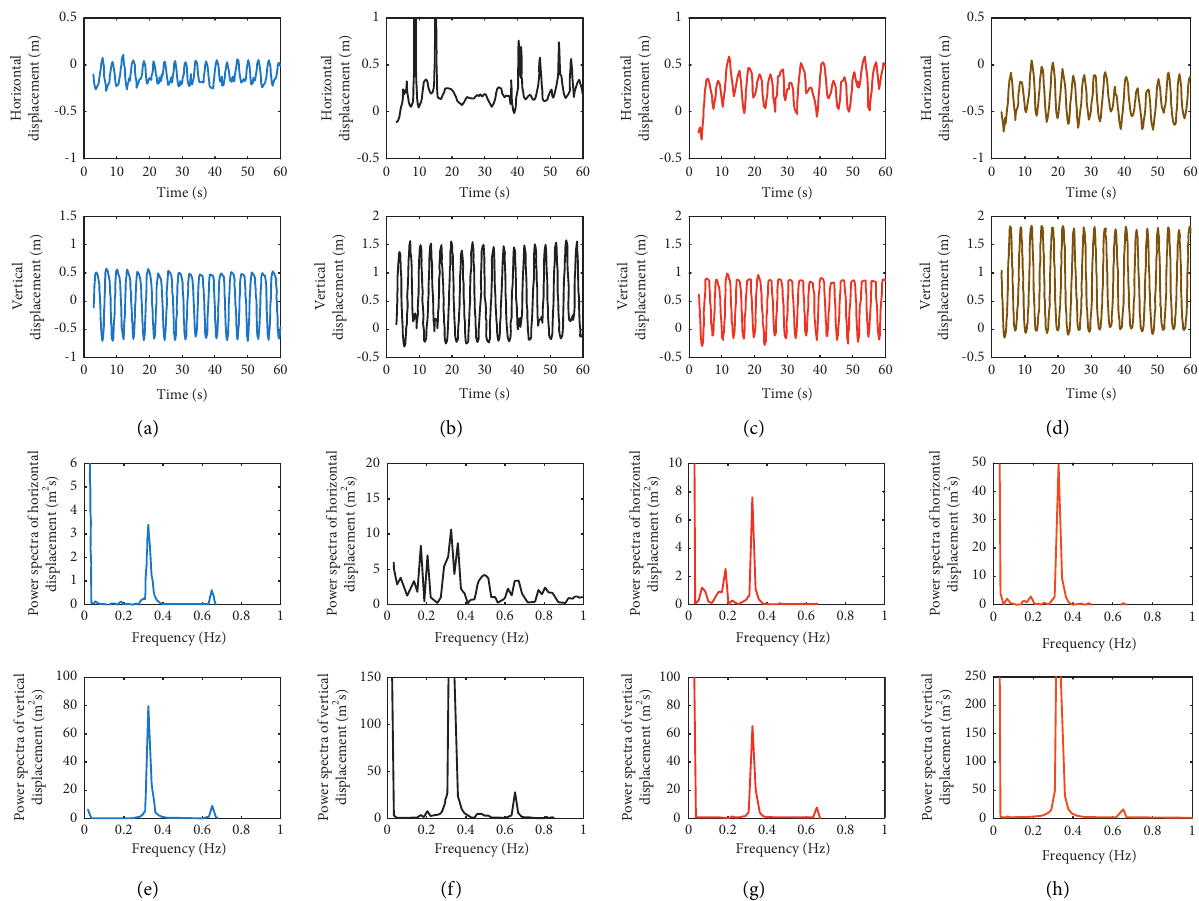
Figure 7: Measured data record of real transmission line galloping test. (a) Horizontal and vertical displacement time history curves of measuring point 1. (b) Horizontal and vertical displacement time history curves of measuring point 2. (c) Horizontal and vertical dis- placement time history curves of measuring point 3. (d) Horizontal and vertical displacement time history curves of measuring point 4. (e) Displacement spectrum at measuring point 1. (f) Displacement spectrum at measuring point 2. (g) Displacement spectrum at measuring point 3. (h) Displacement spectrum at measuring point